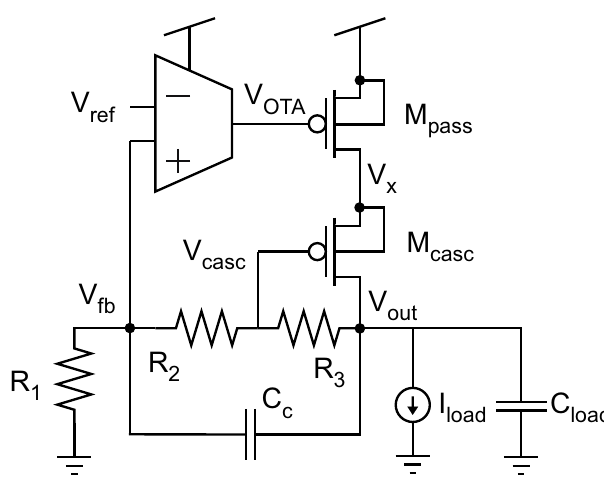
Figure 5. Circuit structure of the proposed